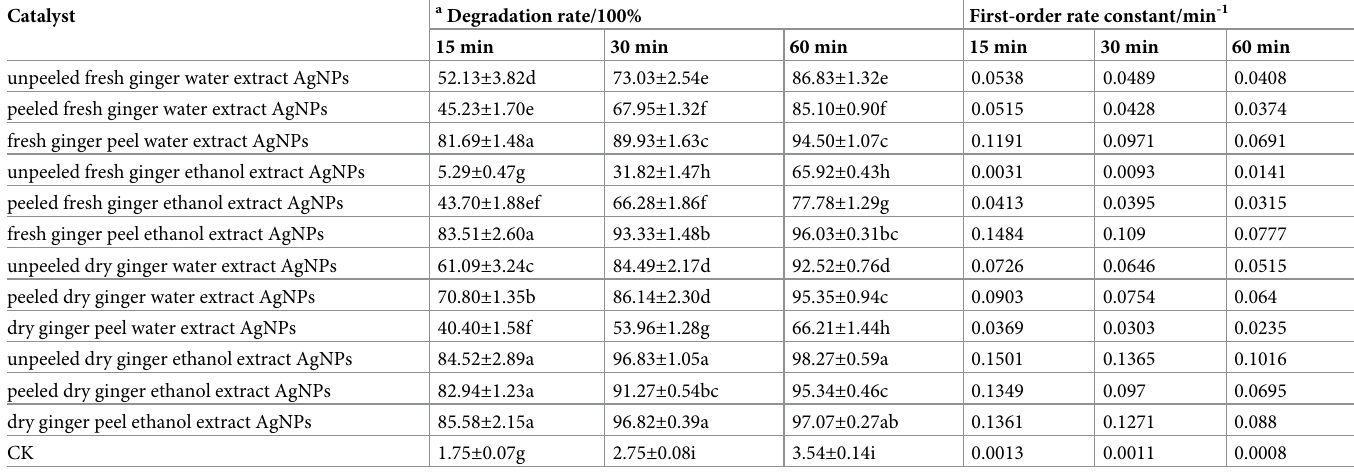
https://doi.org/10.1371/journal.pone.0271408.g006 Table 3. Summary of degradation rate percentage and rate constant for degradation of DB15 catalyzed by Z . officinale AgNPs.